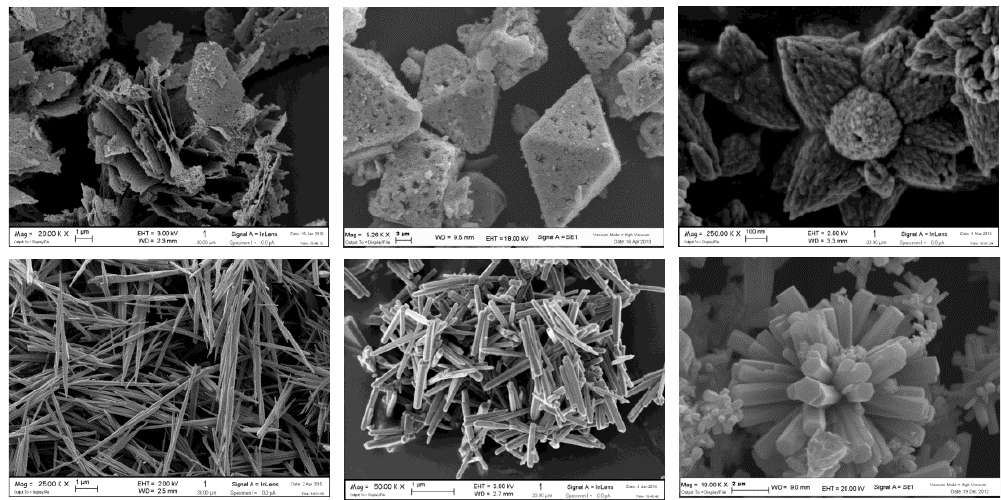
Figure 6. ZnO nanoforms tested toward acetone for breath gas analysis [83].